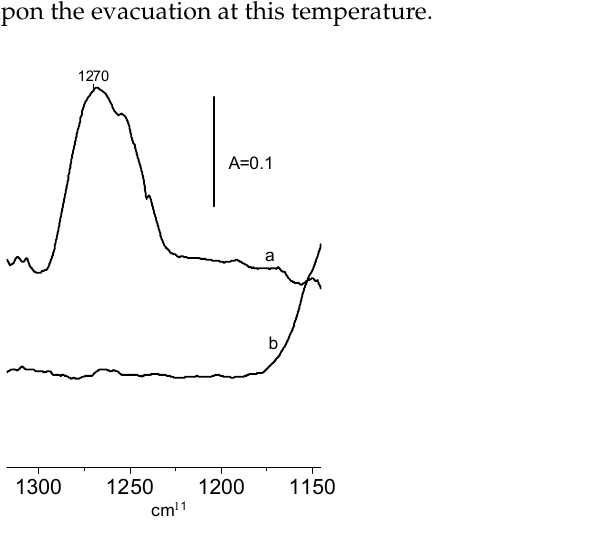
Figure 4. The spectra recorded upon the adsorption of ethanol on CeO 2 at RT (a), and upon the evacuation at 370 K (b).